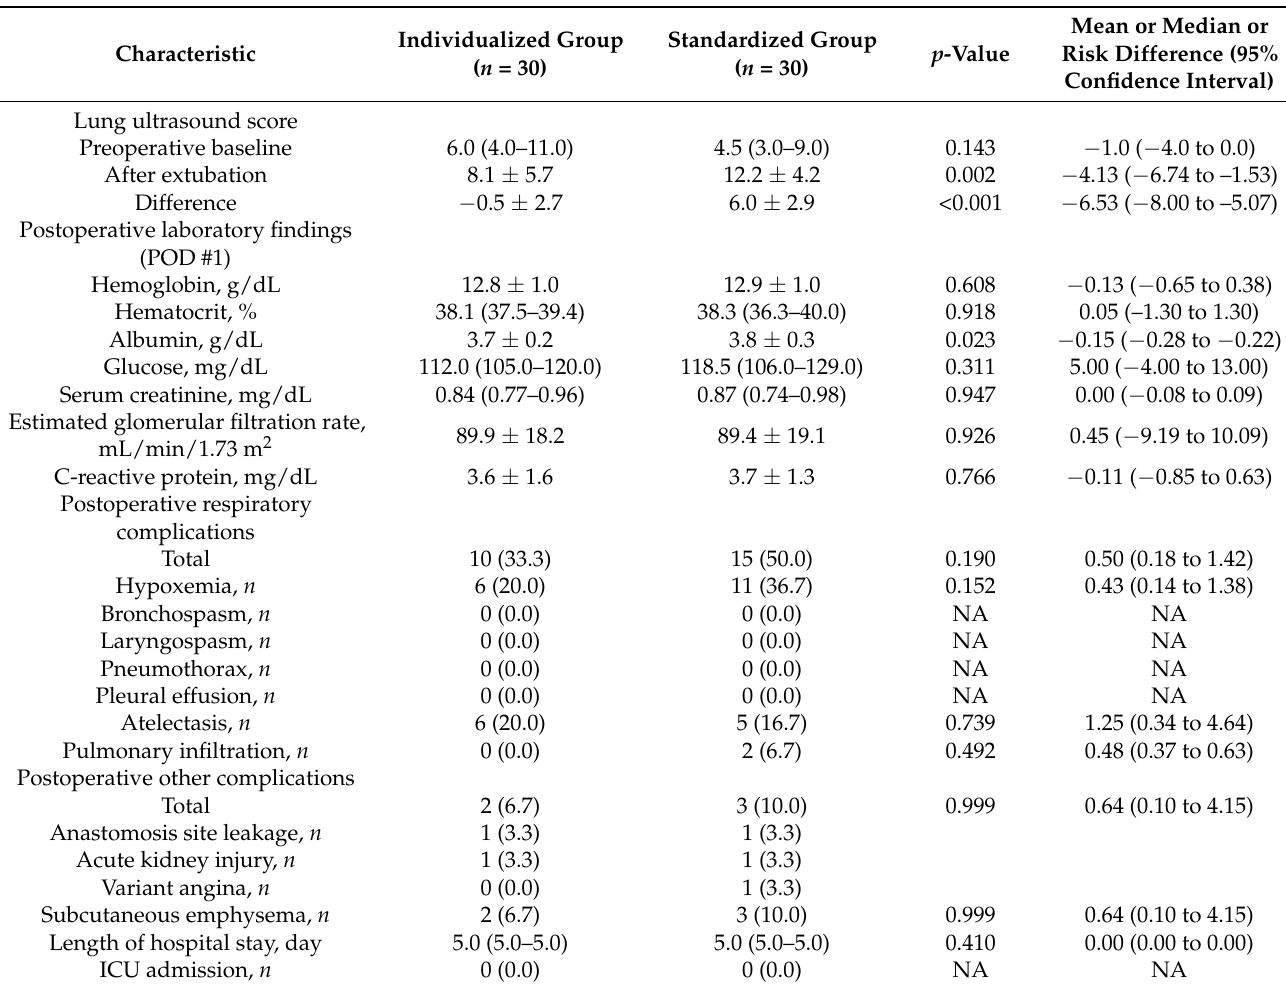
Table 3. Comparison of lung ultrasound scores, postoperative laboratory findings, and complications between the individu- alized and standardized